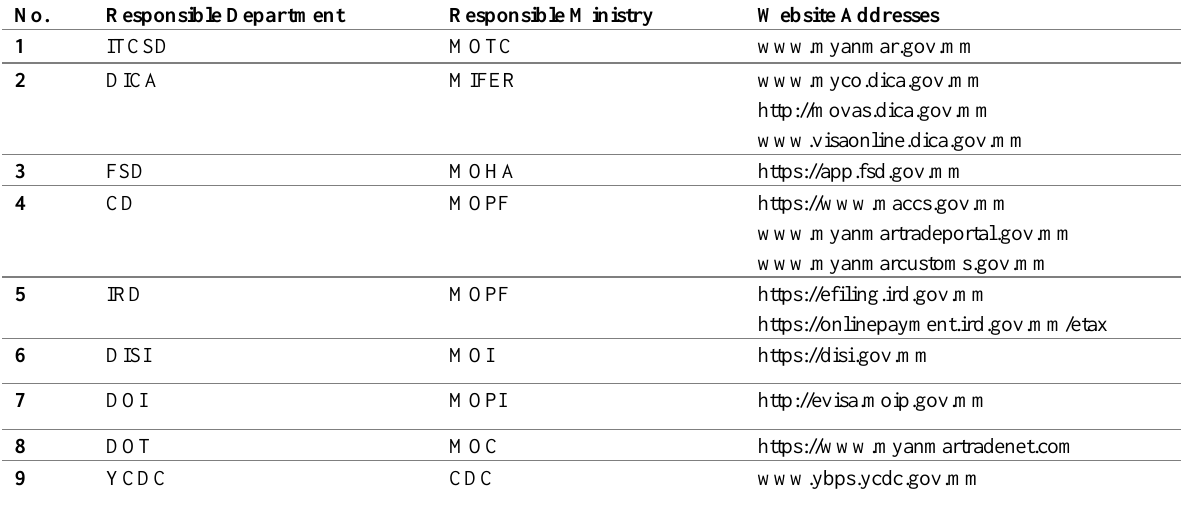
Table 6 : The List of Well-Functioning G2b E-Service Websites in Myanmar